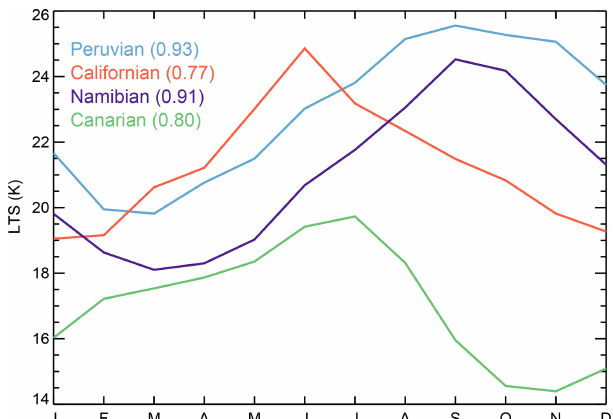
Figure 8. Annual cycle of LTS for the regions delimited in Fig. 6 by the rectangular boxes. The numbers in brackets are the correlation coefficients between the annual cycle of the number of observations (shown in Fig. 7) and these LTS cycles.